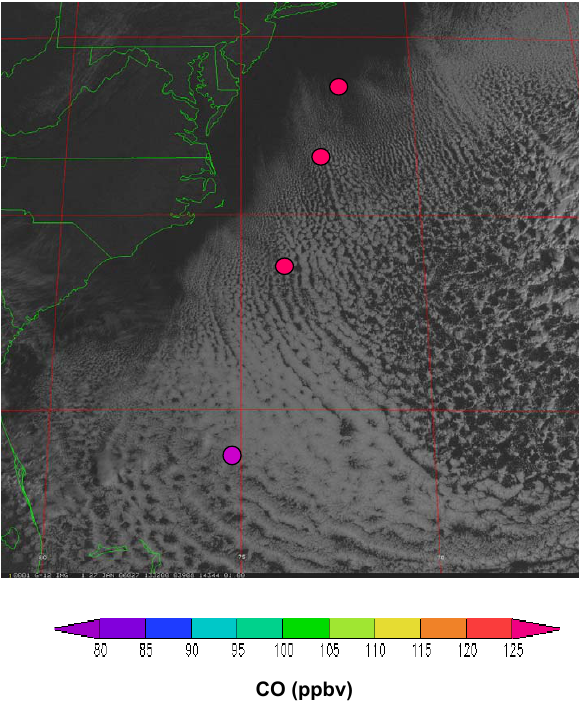
Fig. 9. GOES-12, Band 01, visible, 1km image for 13:31UTC 27 January